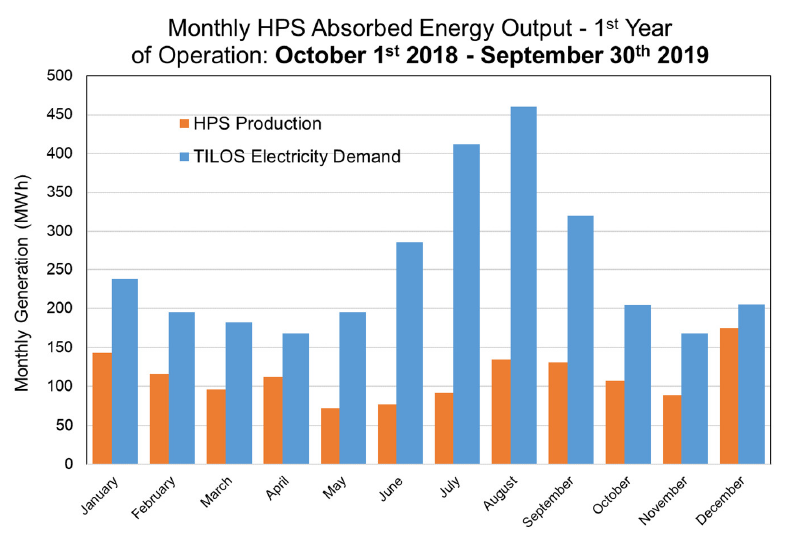
Figure 23. Actual, monthly energy output (absorbed) of Tilos HPS vs. Tilos island electricity consumption, as recorded from HEDNO.